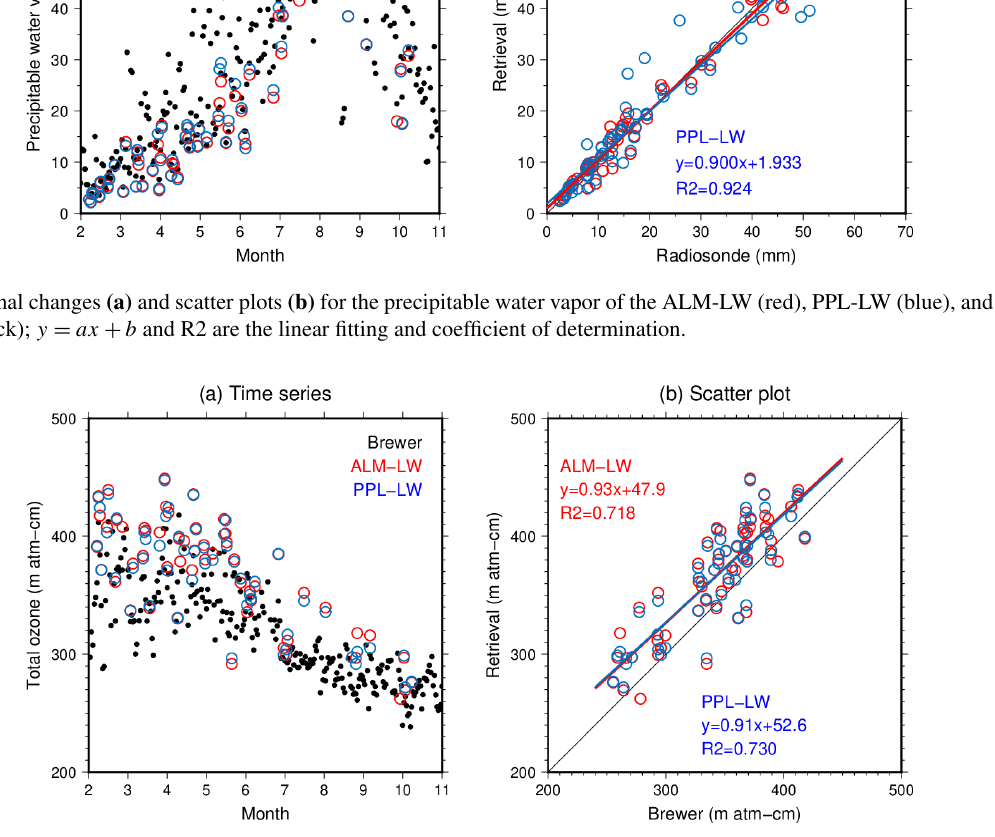
Figure 13. Seasonal changes (a) and scatter plots (b) for the total ozone of the ALM-LW (red), PPL-LW (blue), and Brewer spectropho- tometer observations (black); y = ax + b and R2 are the linear fitting and coefficient of